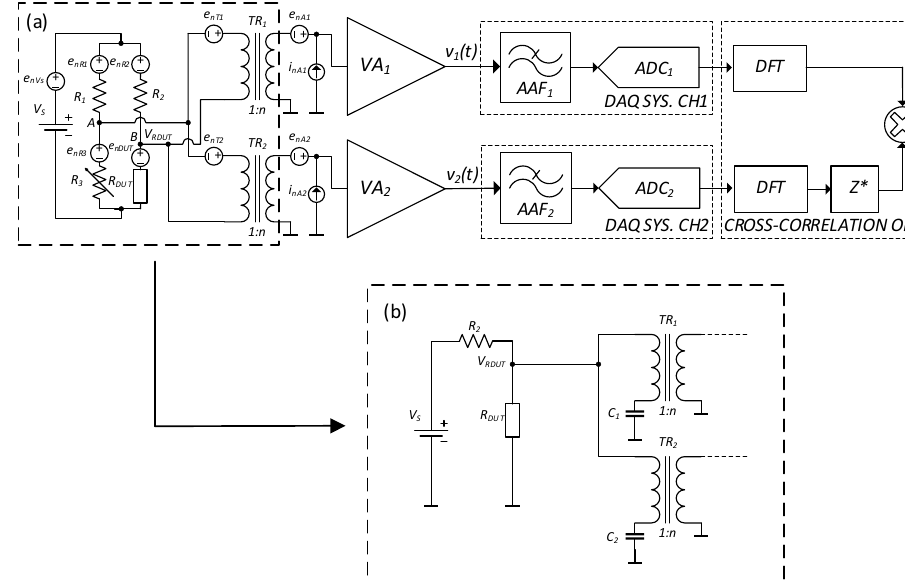
Figure 4. Cross-correlation set-up with transformed coupled amplifiers developed in [19] ( a ) *. The set-up can be greatly simplified, with the added advantage of a lower background noise, modifying the leftmost section as shown in ( b ), according to the approach we propose. * Reprinted with permission from Ref. [19]. Copyright 2022, Elsevier.